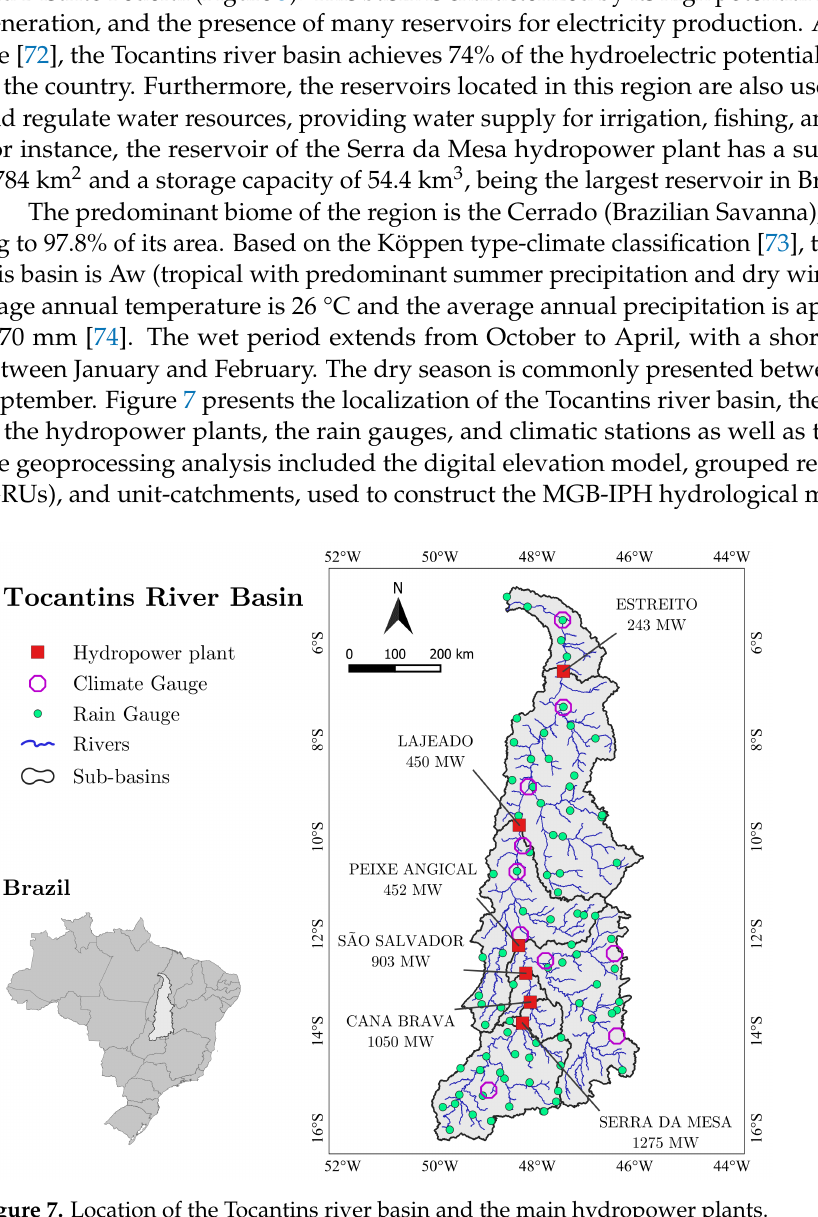
Figure 7. Location of the Tocantins river basin and the main hydropower